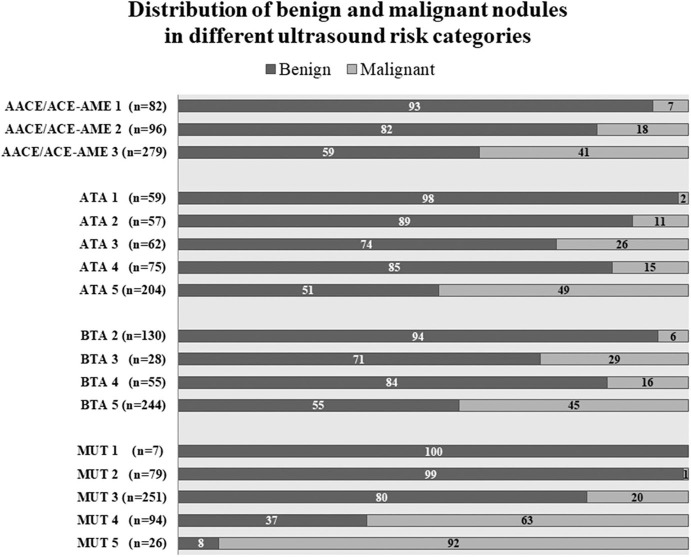
Nodules distribution according to AACE/ACE-AME Task Force on thyroid nodules, American Thyroid Association (ATA), British Thyroid Association (BTA), and Modena US Thyroid Classification (MUT). Benignity and malignancy have been diagnosed histologically according to histology. Numbers in bars are expressed as percentage of the total number of nodules for each category.